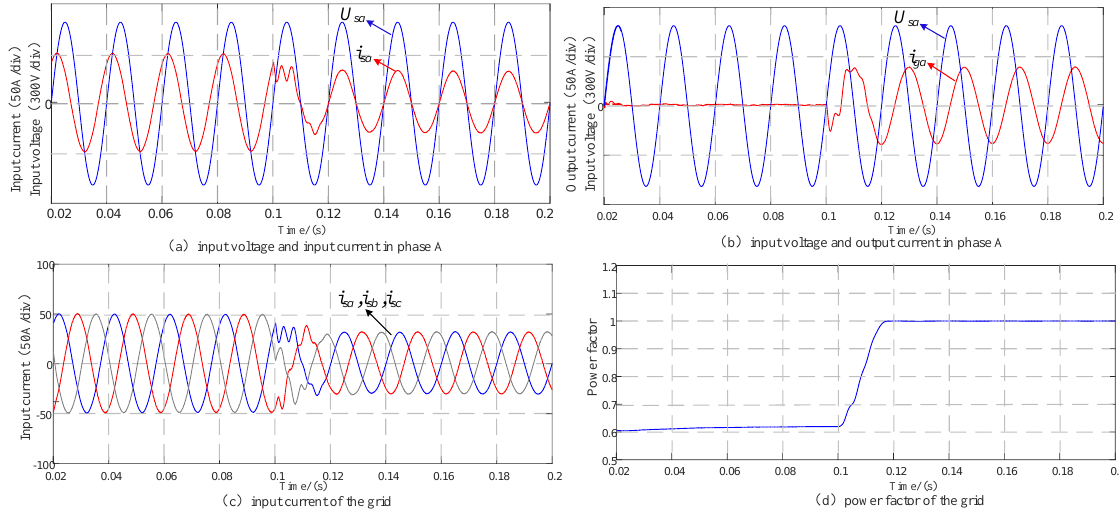
Figure 18. Simulation results of reactive power compensation and power factor correction. ( a ) Input voltage and input current in Phase A; ( b ) input voltage and output current in Phase A; ( c ) input current of the grid; ( d ) power factor of the